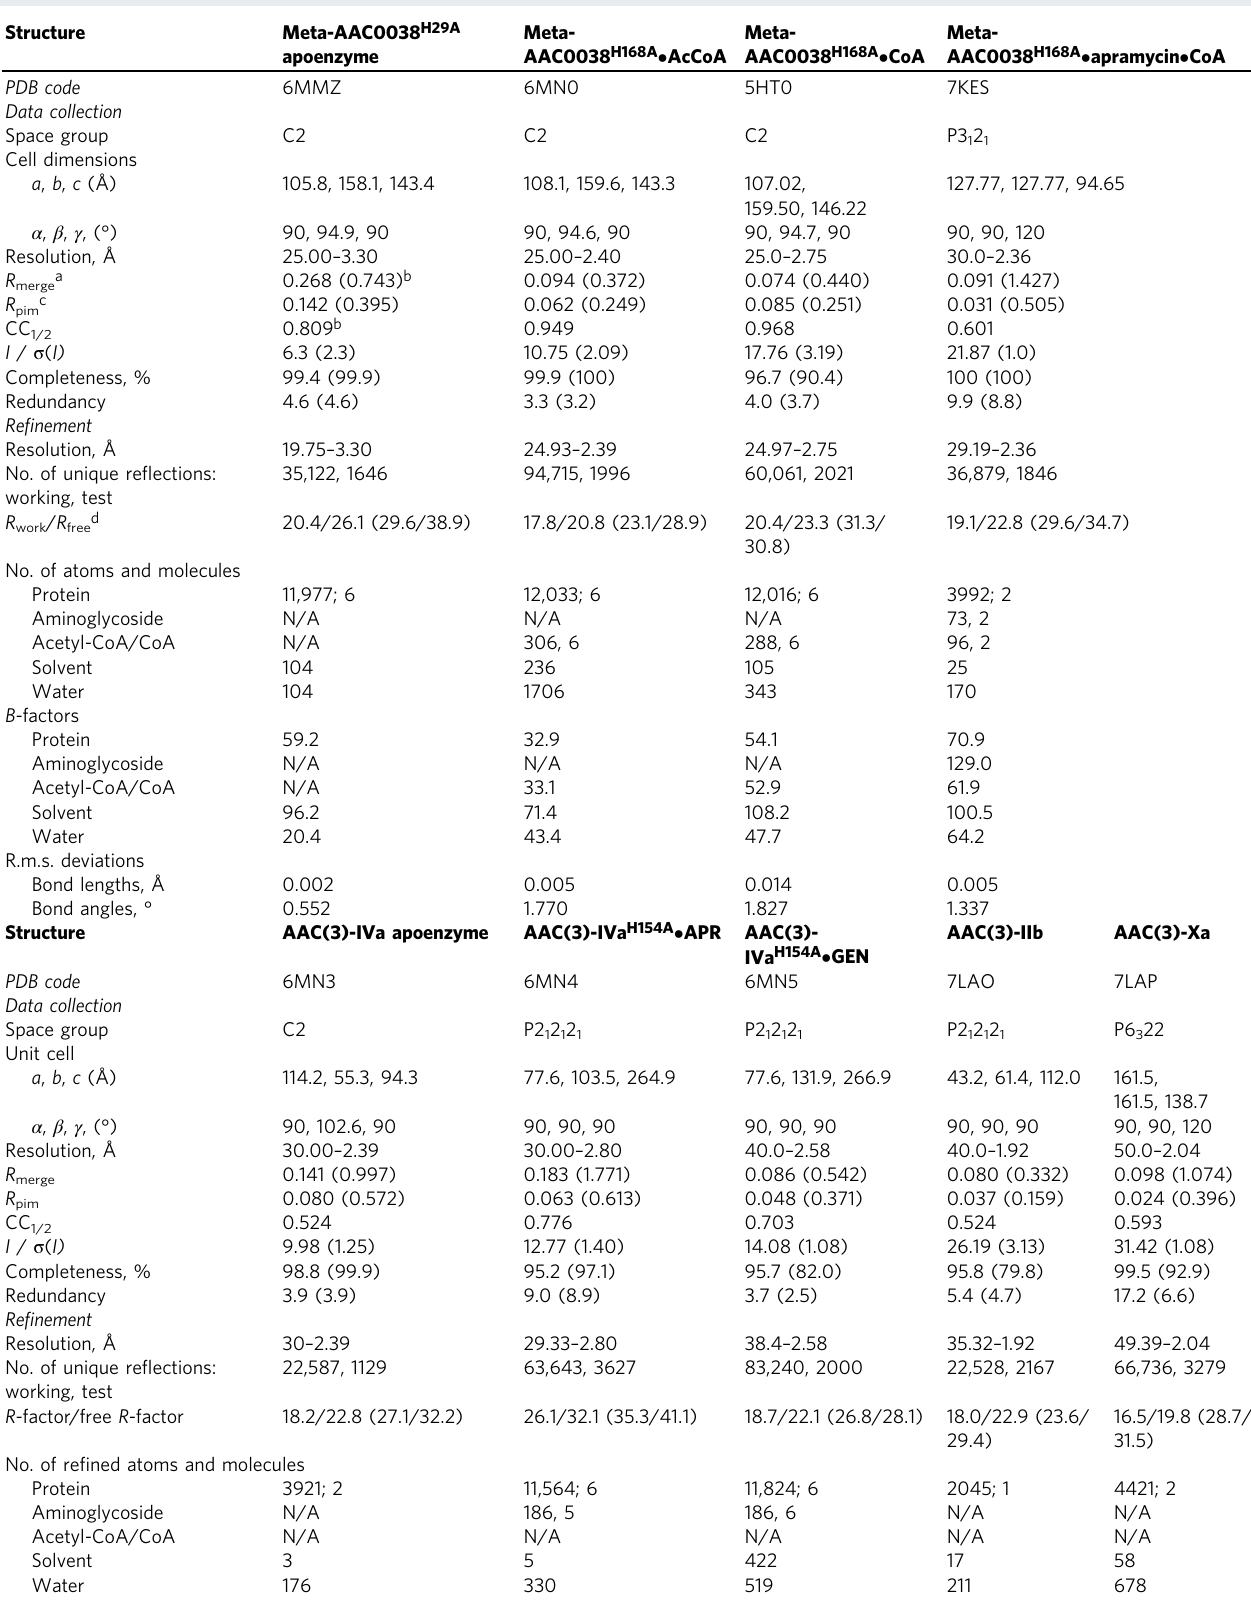
Table 1 X-ray crystallographic statistics.